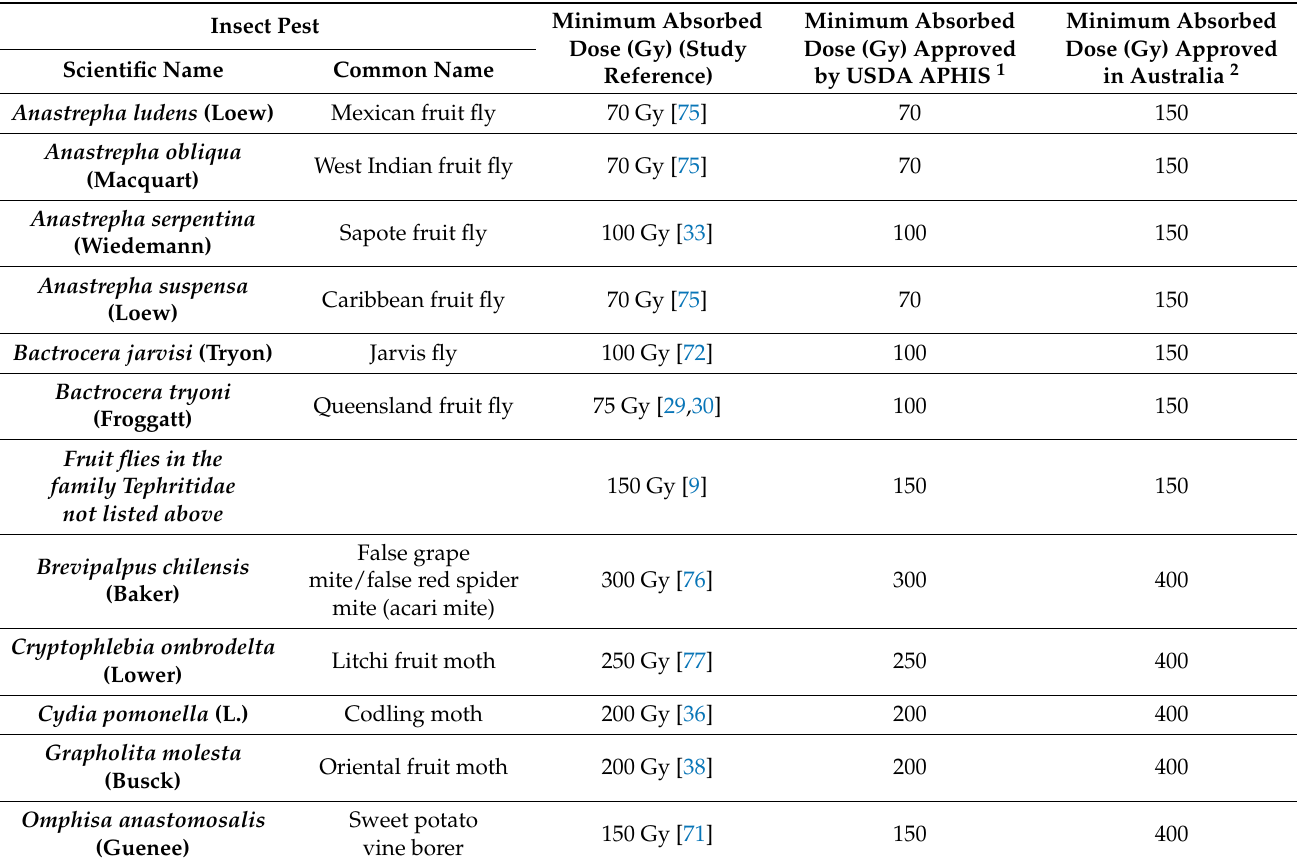
Table 2. Minimum absorbed dose approved for insects/insect groups within Australia and the United